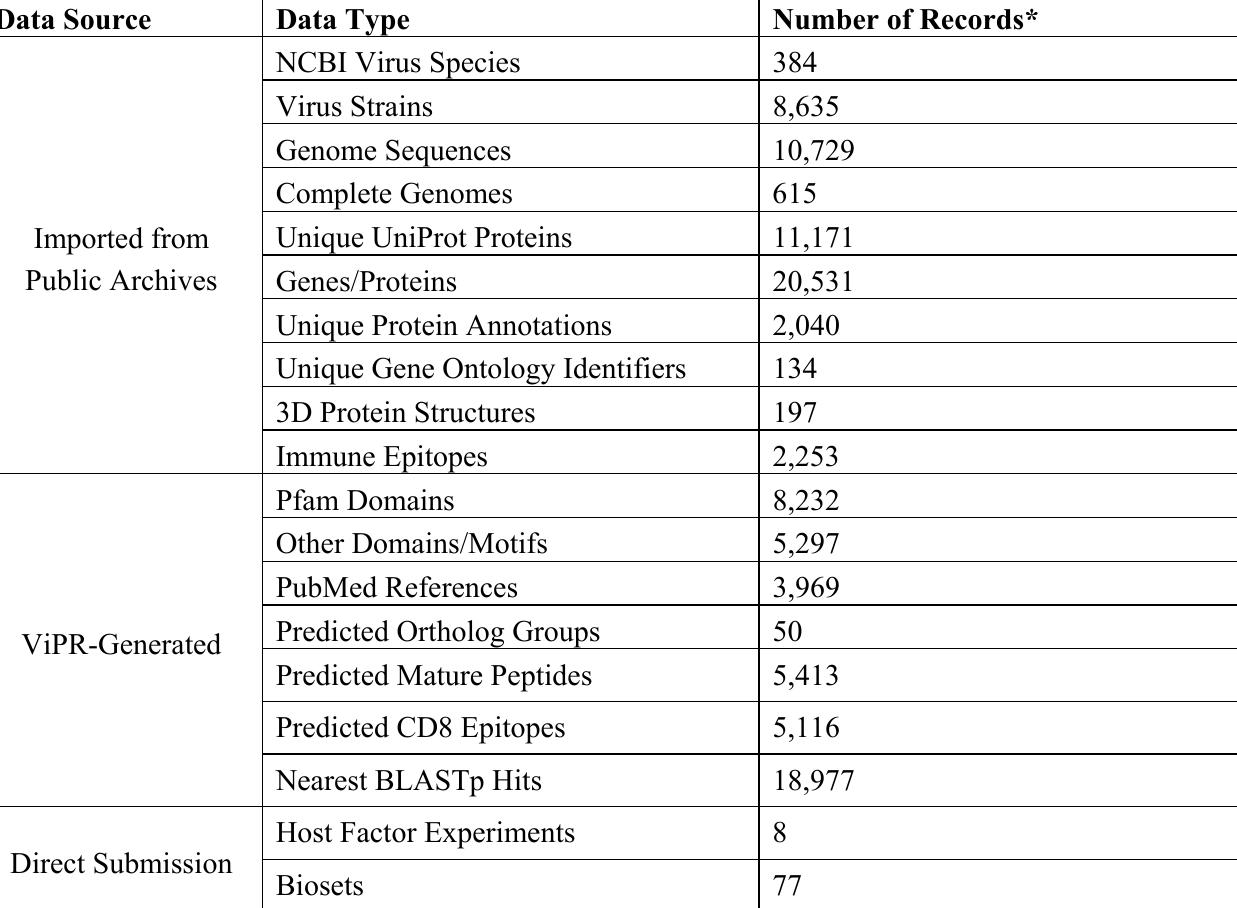
Table 1. Coronaviridae data currently provided within the ViPR